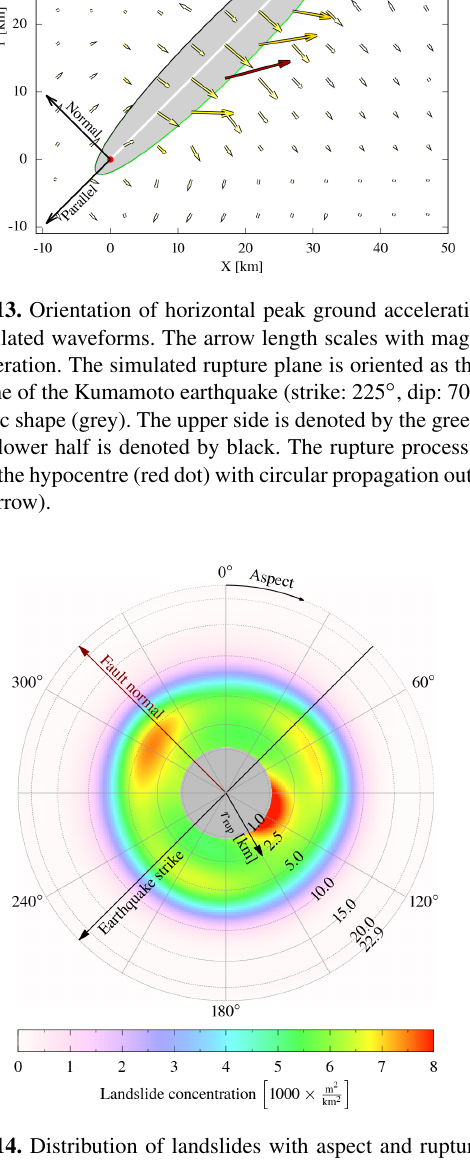
Figure 14. Distribution of landslides with aspect and rupture dis- tance. The rupture distance is measured from the model by Kubo et al. (2016). This model does not completely reach the surface, truncating distances below 1km. The distribution has been normal- ized by the distribution of aspect of the affected area.